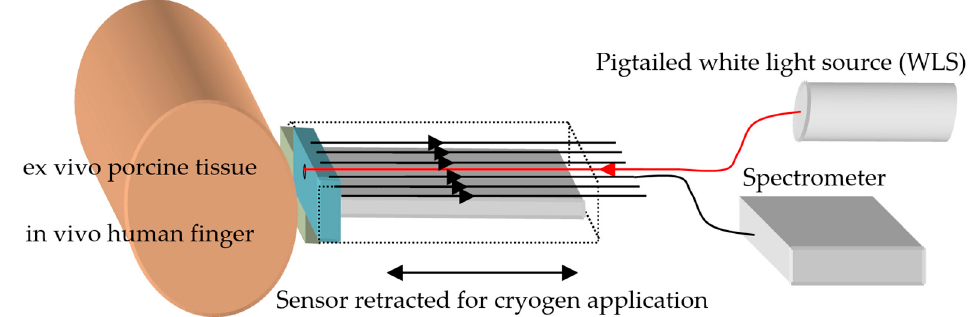
Figure 4. Schematic diagram of experimental setup used for spectral analysis of ex vivo porcine and in vivo human measurements.